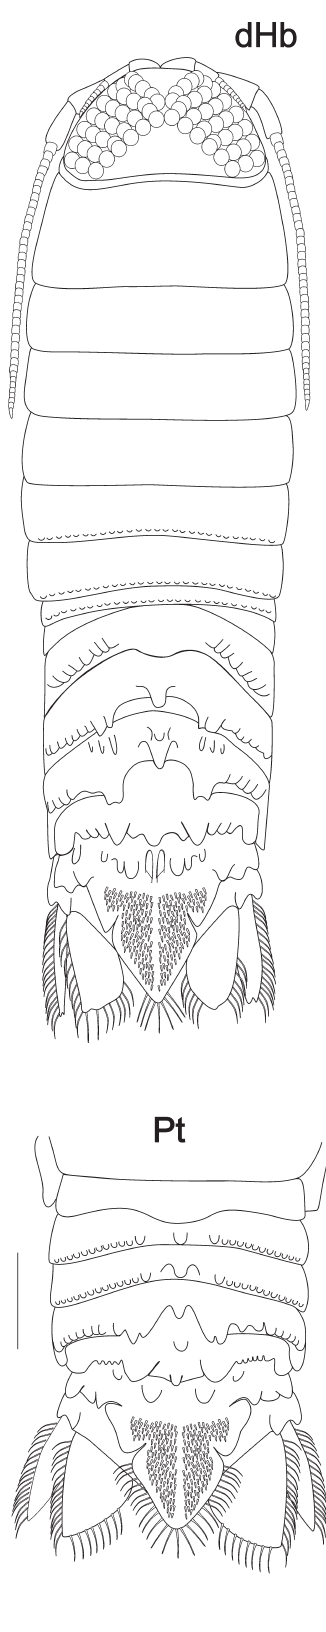
Figure 9. Excorallana oculata (Hansen, 1890), male, 15 mm, (MOUFPE 13.339), habitus, pleotelson, with variations about the number of tubercles on the base. Scales = 2